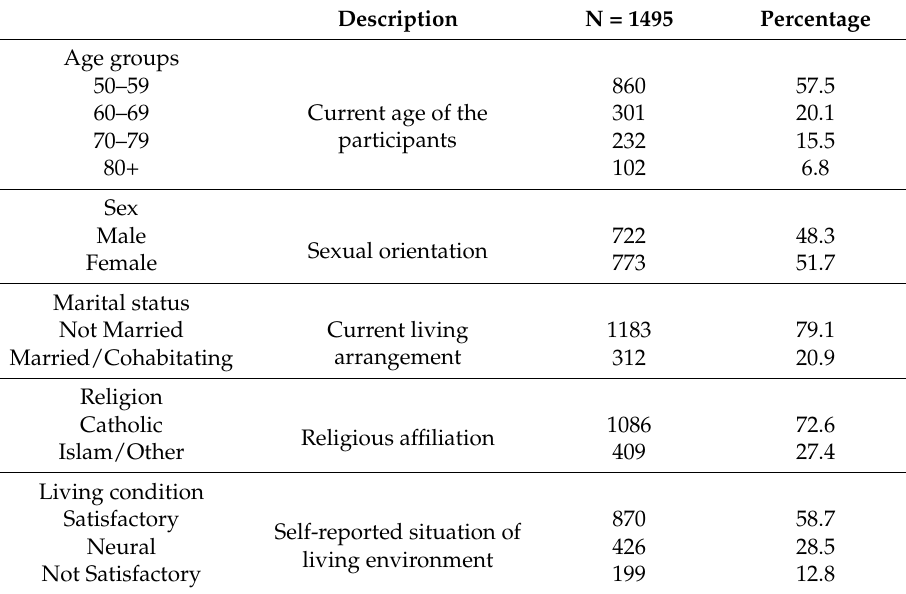
Table 1. Participant characteristics. SAGE WOPS